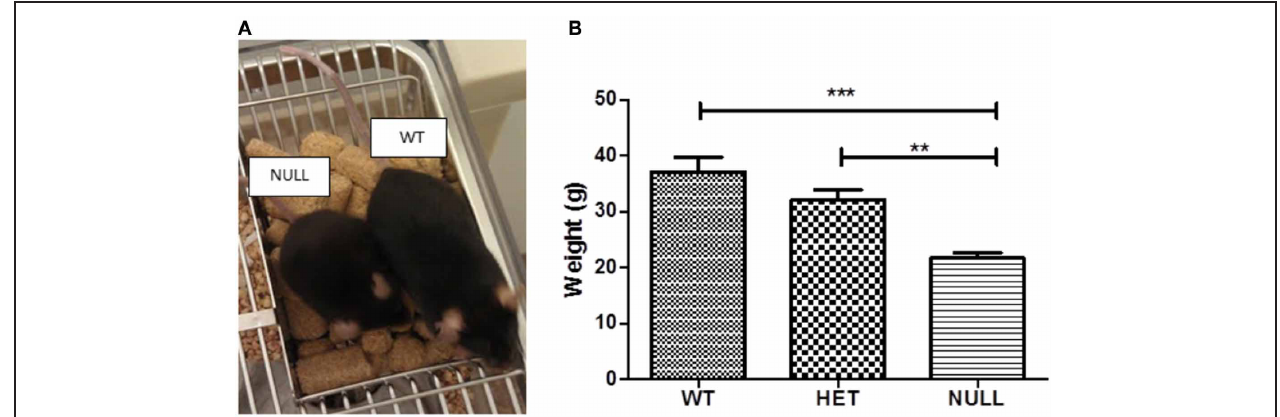
[ F ( 2 , 28 ) = 12 . 33, p < 0 . 001] and heterozygous [ F ( 2 , 28 ) = 12 . 33, p < 0 . 01] mice and this phenotype is maintained throughout the life of the animals (data not shown). Each column represents the average of 8–12 animals.